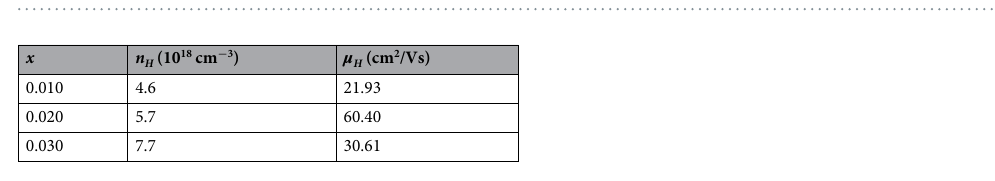
Table 1. Room temperature electron concentration, n H , and carrier mobility, µ H , of Mg 2 Ge 1– x Bi x .